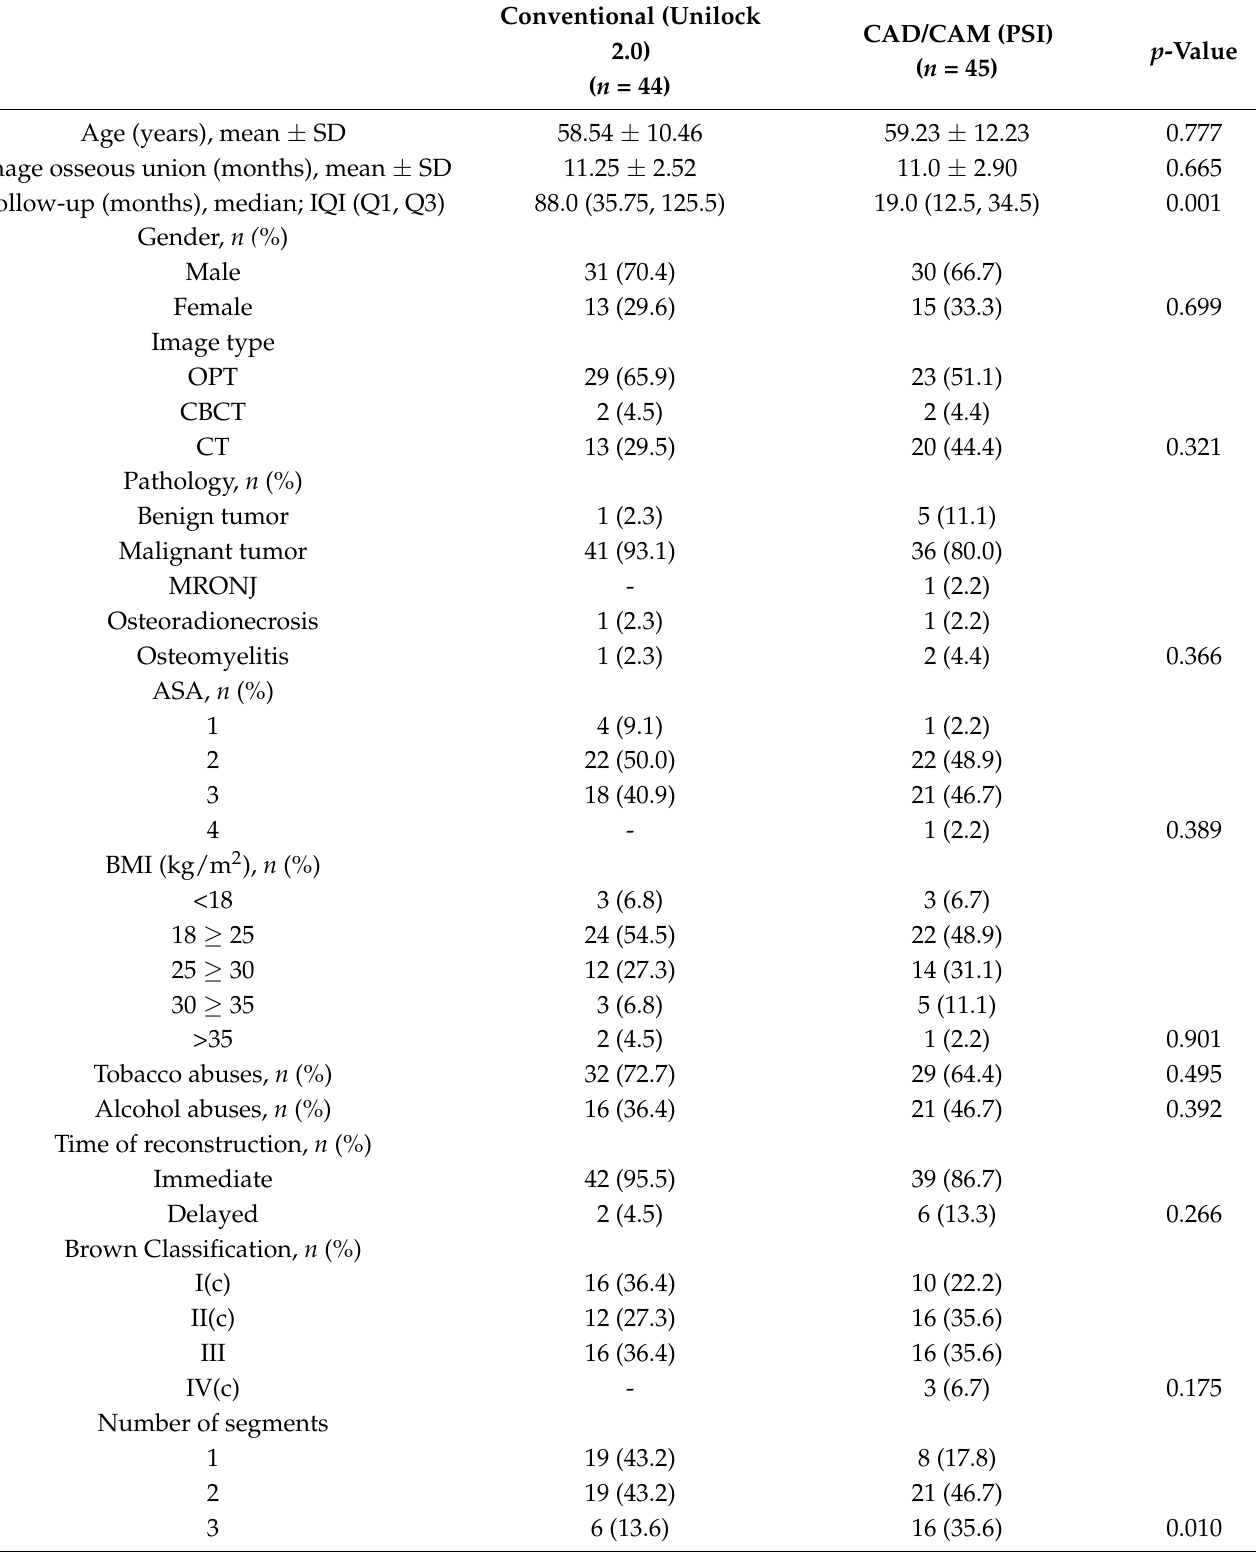
Table 1. Details of the study sample. Conventional osteosynthesis with Unilock 2.0 system (DePuy Synthes CMF, Oberdorf, Switzerland), CAD/CAM-osteosynthesis with PSI (KLS Martin, Tuttlingen, Germany). IQI: Interquartile interval; MRONJ: Medication-related osteonecrosis of the jaw; PSI: patient-specific implant; Q: quartile; SD: standard